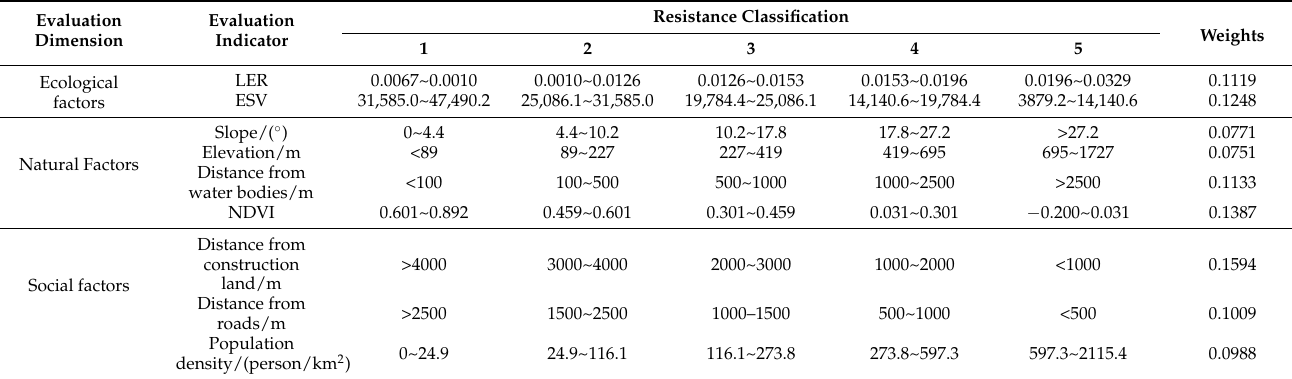
Table 2. Ecological resistance index and grading evaluation